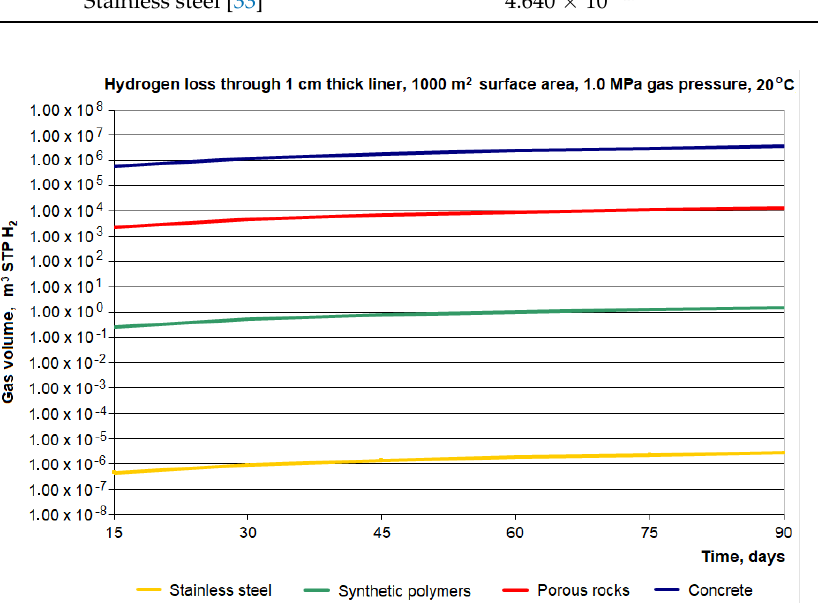
Figure 4. Calculated hydrogen leaks through different types of materials (1 cm thick, 1000 m 2 surface area, 1.0 MPa of gas pressure, 20 °C).